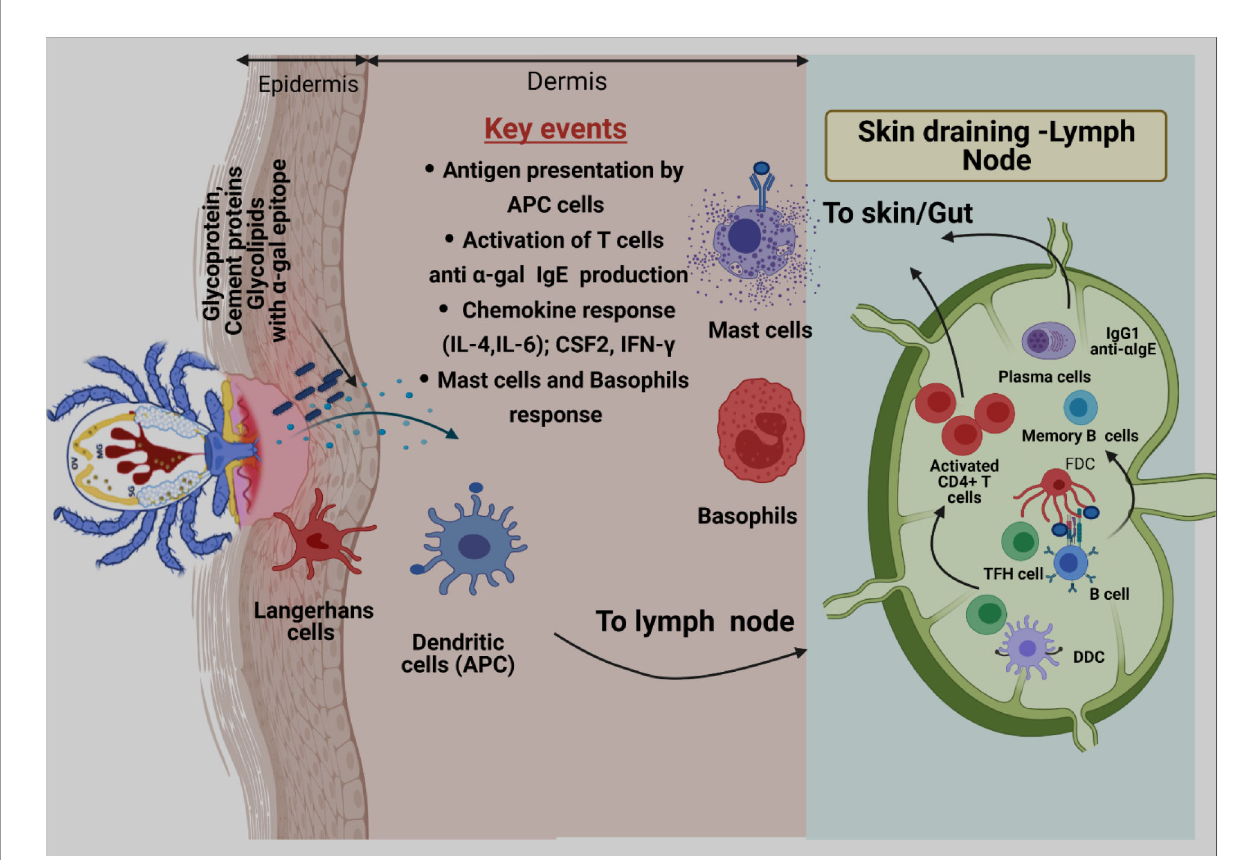
FIGURE 2 | Proposed model of a -gal sensitization from tick bites. Skin is comprised of three layers: epidermis, dermis, and hypodermis. Antigen-presenting cells (APCs), including Langerhans cells (LCs) and dermal Dendritic cells (DCs) residing in epidermis and dermis, respectively, respond to tick-secreted antigens, such as glycoproteins, glycolipids, and tick cement-containing a -gal moieties. After antigen exposure, APCs process antigen, migrate to skin-draining lymph nodes, and participate in allergen sensitization. During this process, naïve T cells are primed through presentation of tick a -gal antigens by LCs and dermal DCs within skin- draining lymph nodes. Activated CD4 + T cells subsequently traf fi c to the skin through blood and lymphatic vessels. Cognate T cell help, provided by T follicular helper (TFH) cells, to a -gal-speci fi c B cells leads to germinal center responses, positive clonal selection of B cells via recognition of native antigens retained by follicular dendritic cells (FDCs), and the development of memory B cells and plasma cells. After clonal selection, B cells migrate to the tick bite site on the skin to manifest allergic responses by presenting antigens to T cells, secreting proin fl ammatory cytokines, and secreting a -gal-speci fi c antibodies (anti- a -IgE) that ultimately triggers activation of mast cells and basophils and allergic